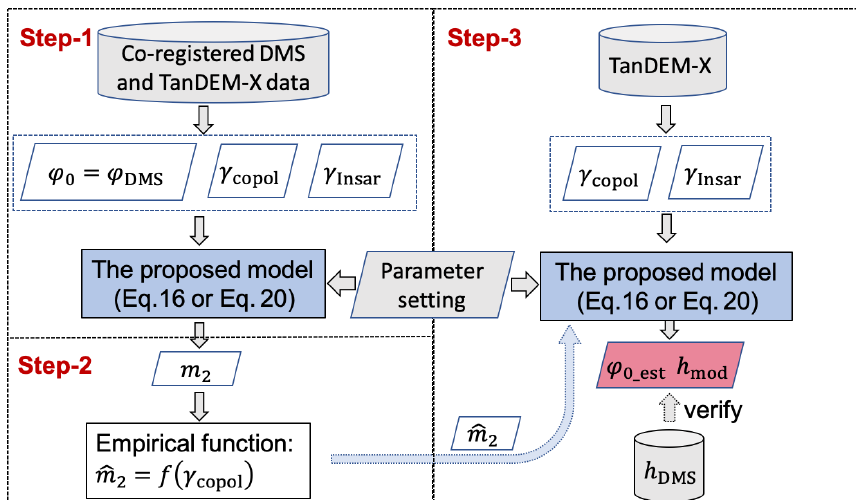
Figure 11. Flow chart of the proposed inversion method.